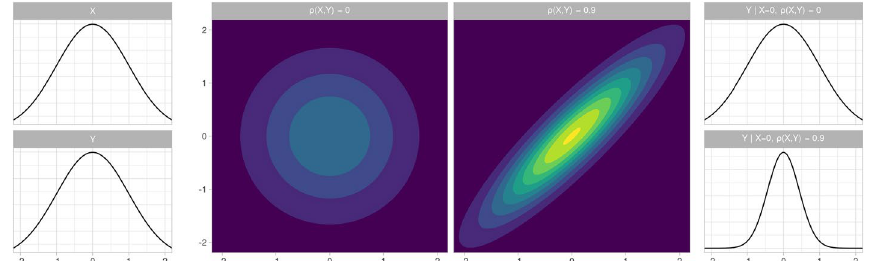
Fig. 1 Comparisons of marginal and conditional densities for multivariate normal distributions. Left: Marginal densities of variables X and Y after standardisation. Middle: Multivariate contour plots of the two‑dimensional densities of X and Y, with either no correlation or a strong correlation between them. Right: Conditional densities of variable Y conditional on X when there is either no correlation or a strong correlation between variables X and